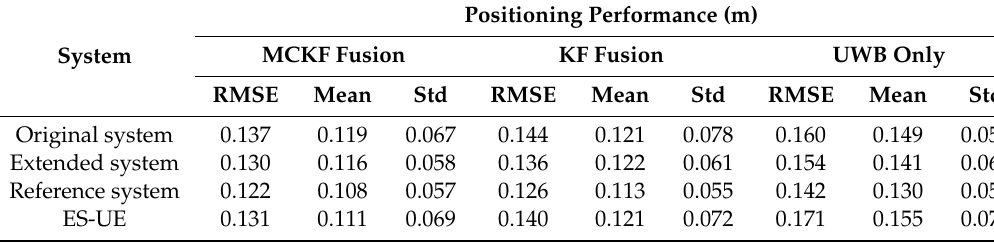
Figure 13. Positioning effect in an unfamiliar environment. Table 5. Positioning error using di ff erence